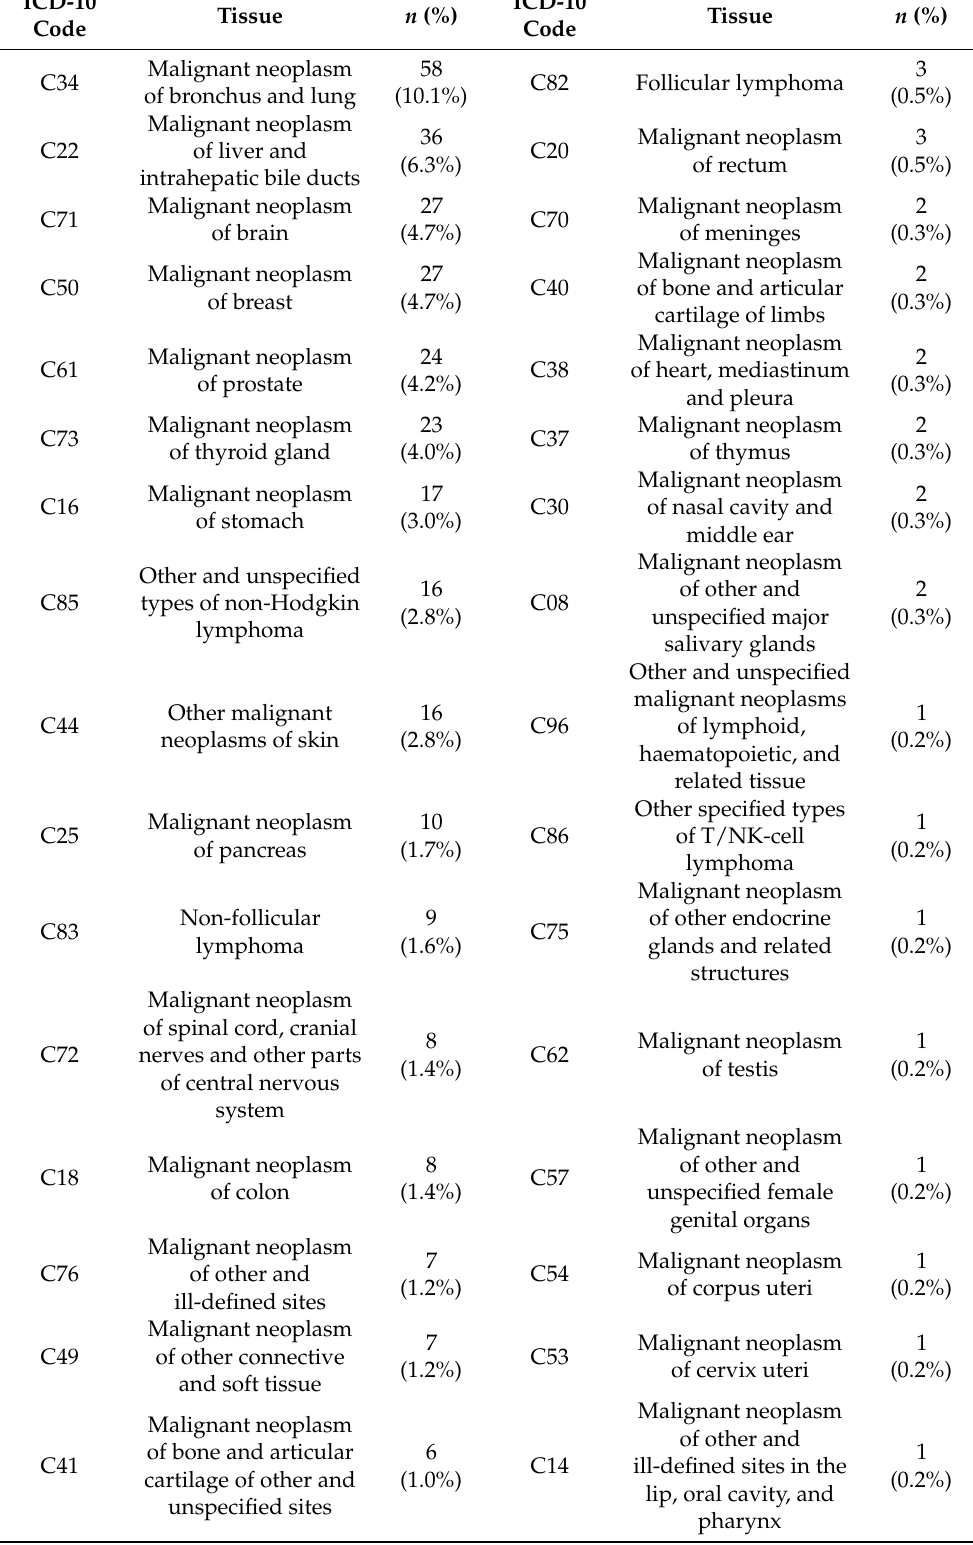
Table 1. Coexisting cancers associated with uveal